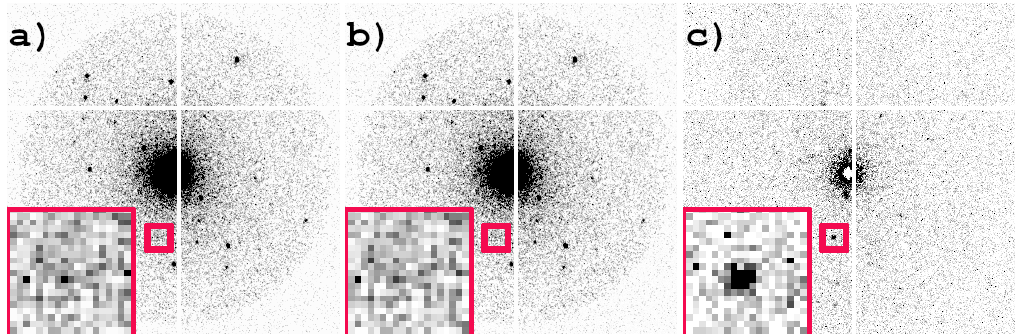
Figure 6. Noise reduction by application of a 10 keV threshold. ( a ) Frame with 10 keV threshold applied, ( b ) frame without threshold applied, ( c ) frame ( a )–frame ( b ) reveal “hidden” reflections. The insets show a magnified version of the region of interest. Images including background